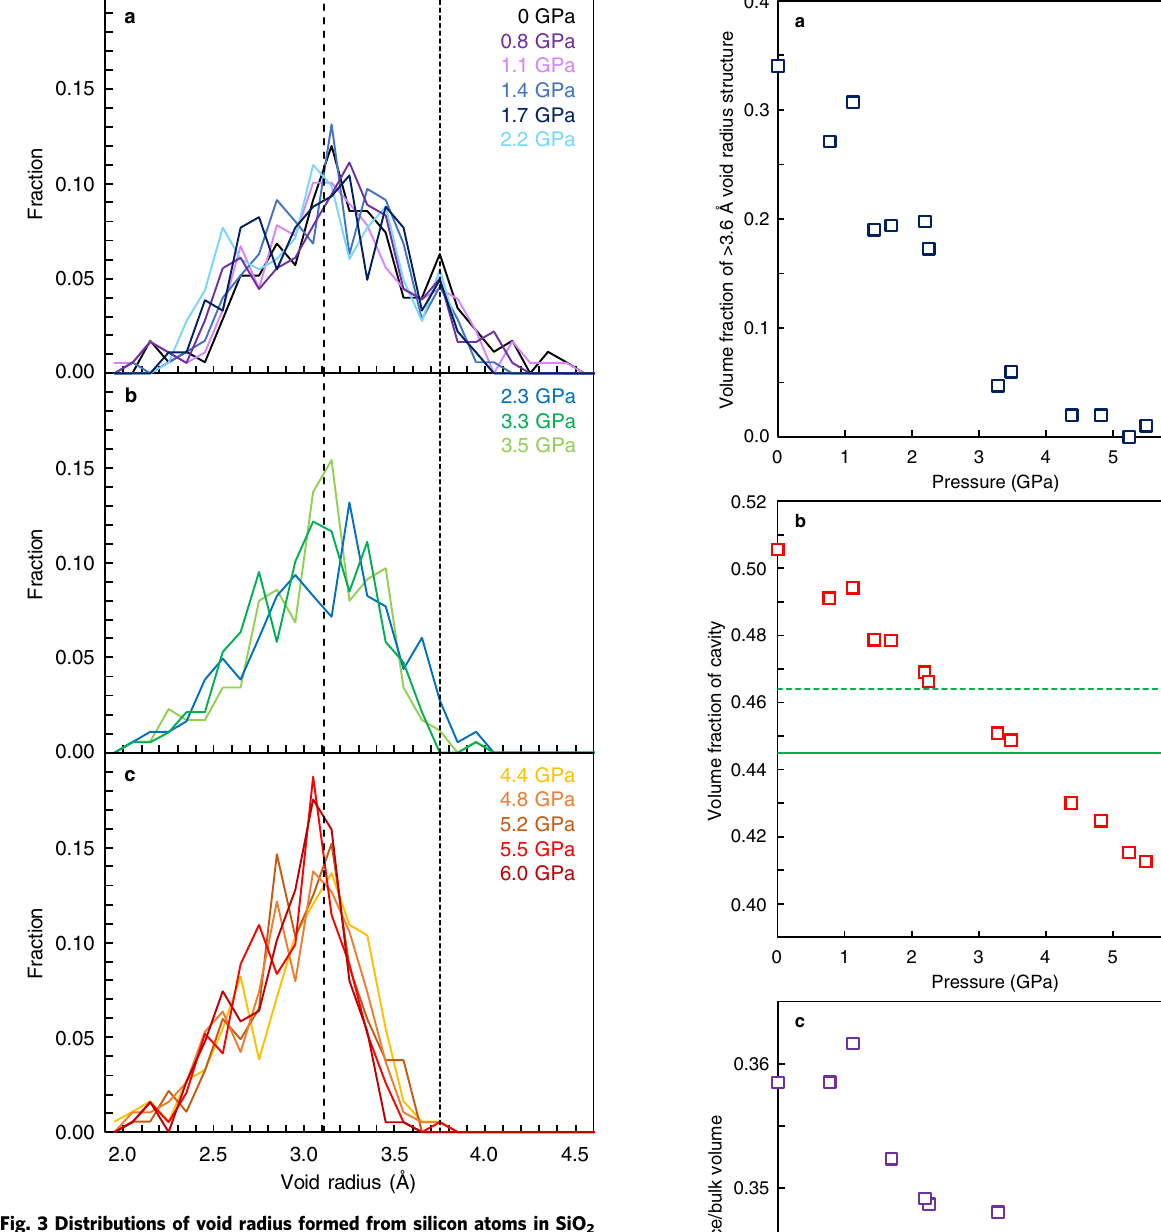
Fig. 3 Distributions of void radius formed from silicon atoms in SiO 2 glass at high pressures. a 0 – 2.2 GPa. b 2.3 – 3.5 GPa. c 4.4 – 6.0 GPa. The broken line at the void radius of 3.11 Å represents the ring size of a six- membered ring structure. The dotted line at the void radius of 3.75 Å is a guide for the eye. Source data are provided as a Source Data fi